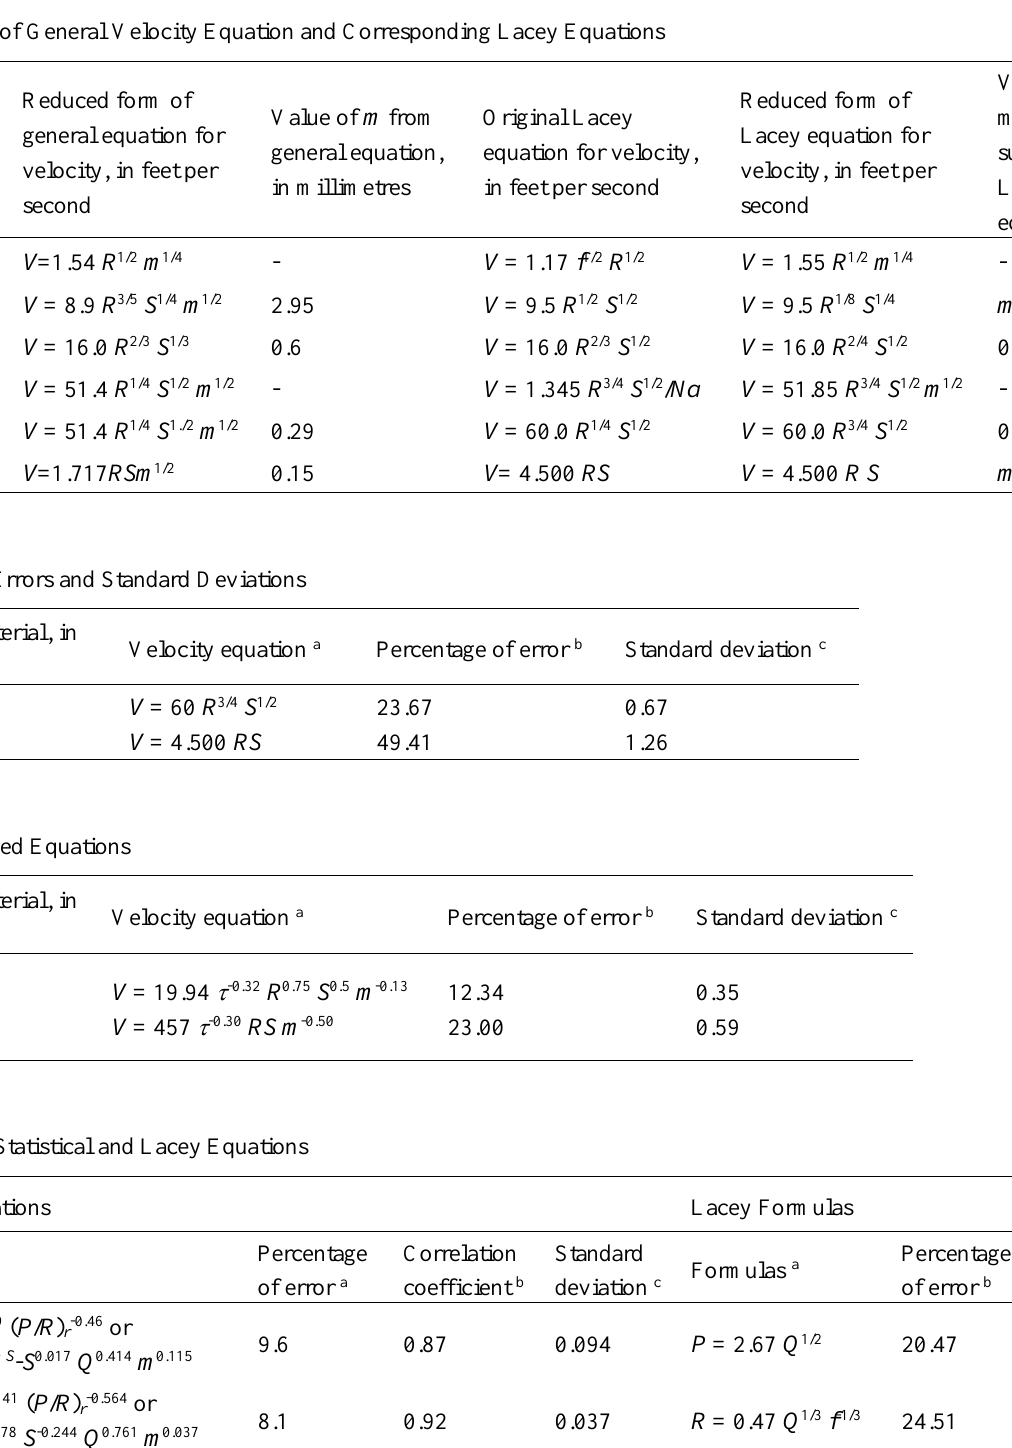
Different Forms of General Velocity Equation and Corresponding Lacey Equations Values of Reduced form of exponent x in general equation for general equation